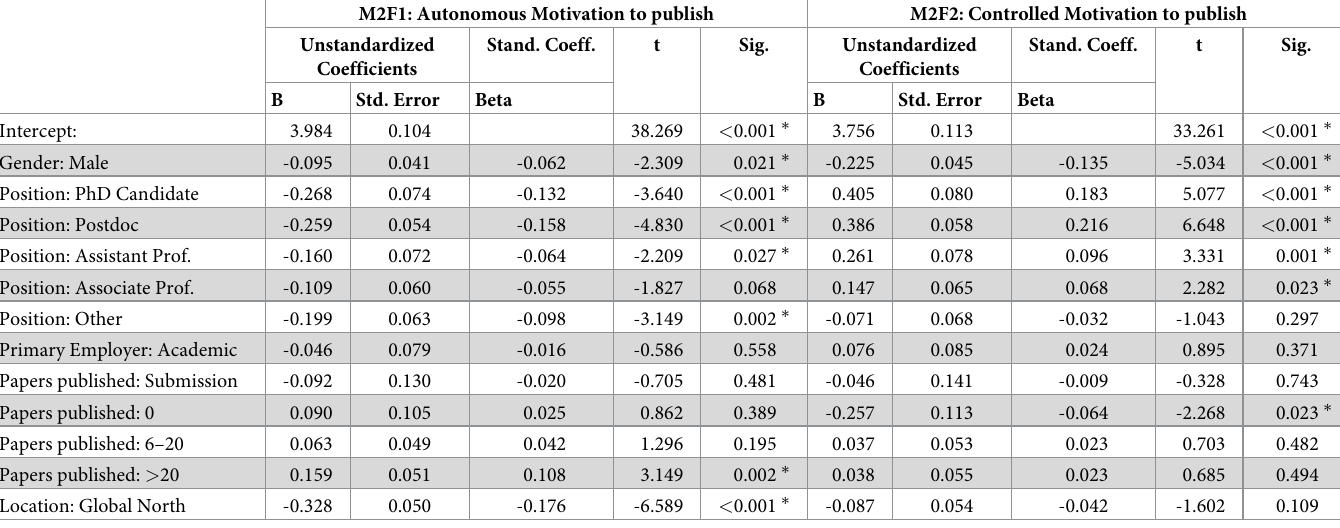
Table 2. Regression models of DV = M2F1 & M2F2 (both N = 1361); regressed onto the control variables. M2F1: Autonomous Motivation to publish